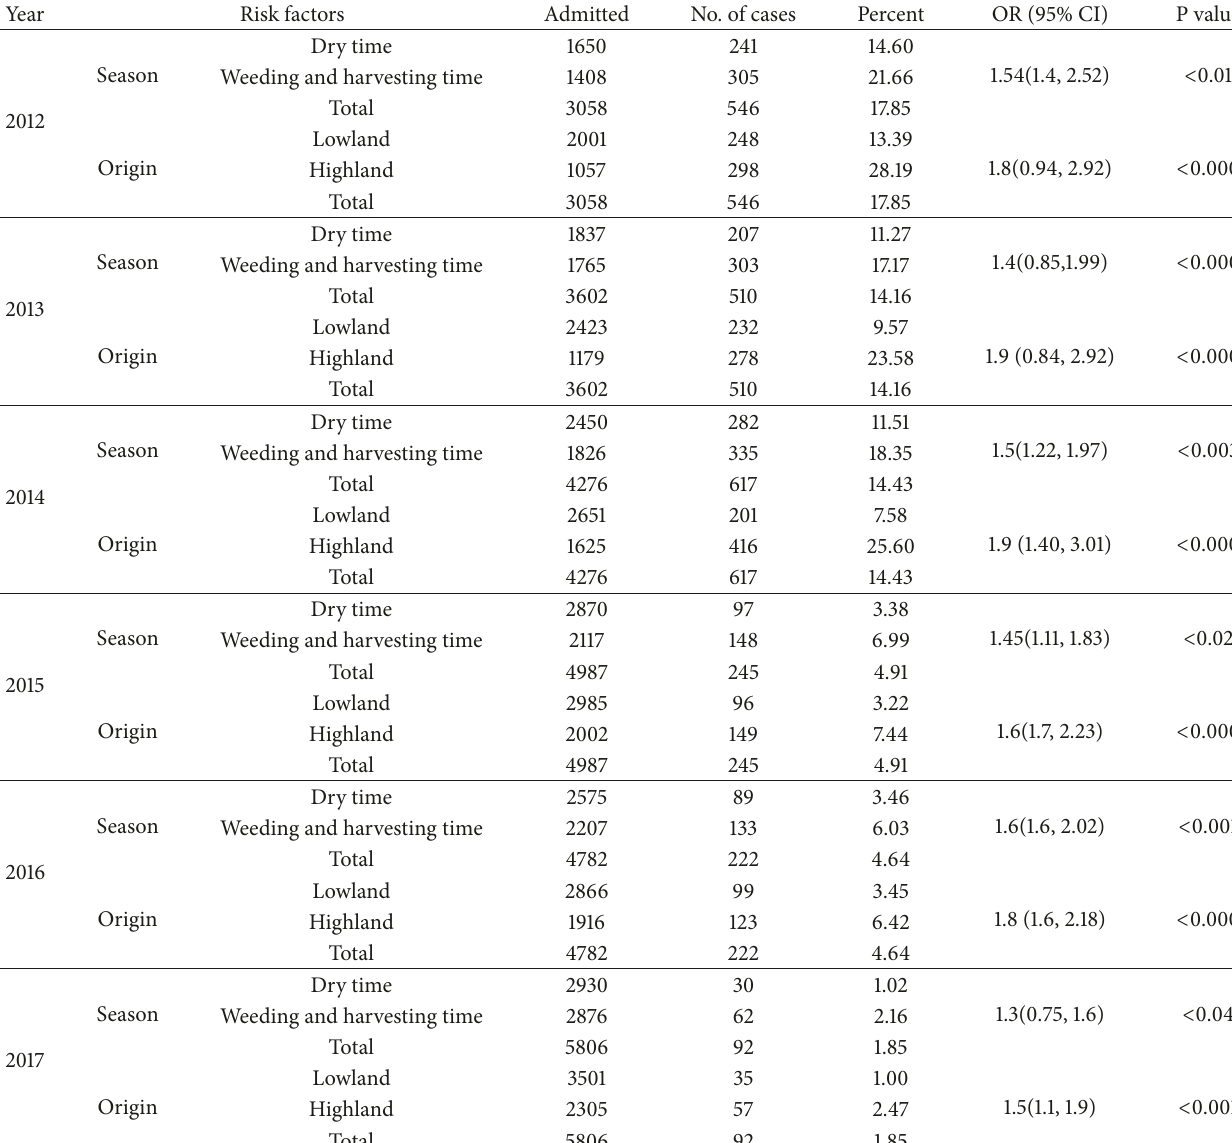
Table 4: Incidence of leishmaniasis in relation to season and origin with all diagnosed patients for